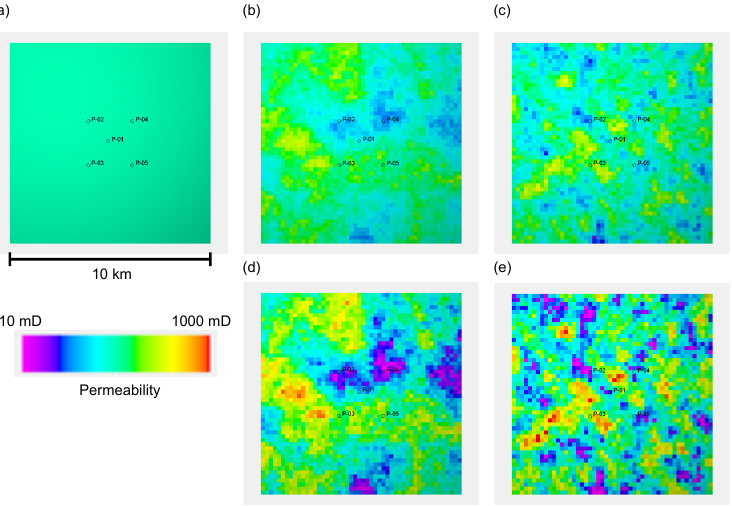
Figure 4. The five models with different porosity and permeability distributions used in the study. The permeability distribution of layer 6, which is the uppermost layer of the reservoir formation, is depicted. ( a ) Homogeneous property distribution of φ = 20% and k = 100 mD; ( b ) Permeability distribution obtained with the φ – k relationship 1 shown in Figure 3, based on the porosity distribu- tion with a horizontal correlation length ( θ h ) of 3000 m; ( c ) Permeability distribution with the φ – k relationship 1 based on the porosity distribution with θ h = 1000 m; ( d ) Permeability distribution with the φ – k relationship 2, based on the porosity distribution with θ h = 3000 m; ( e ) Permeability distribution with the φ – k relationship 2, based on the porosity distribution with θ h = 1000